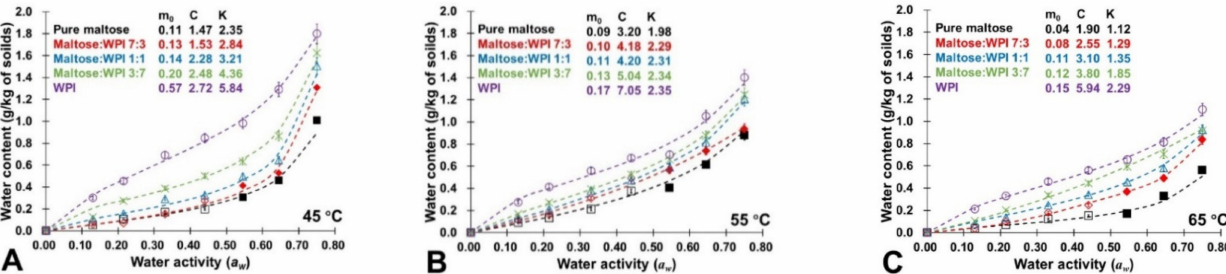
Figure 1. The experimental water sorption (empty points, 0.11~0.44 a w ) and calculated water content data (solid points, 0.56~0.76 a w ) for the amorphous maltose/WPI mixtures at the studied storage conditions. The GAB-derived monolayer value ( m 0 ) and constants C GAB and K GAB for each studied sample were calculated and shown. ( A ) Water sorption data derived from 45 ◦ C; ( B ) Water sorption data derived from 55 ◦ C; ( C ) Water sorption data derived from 65 ◦